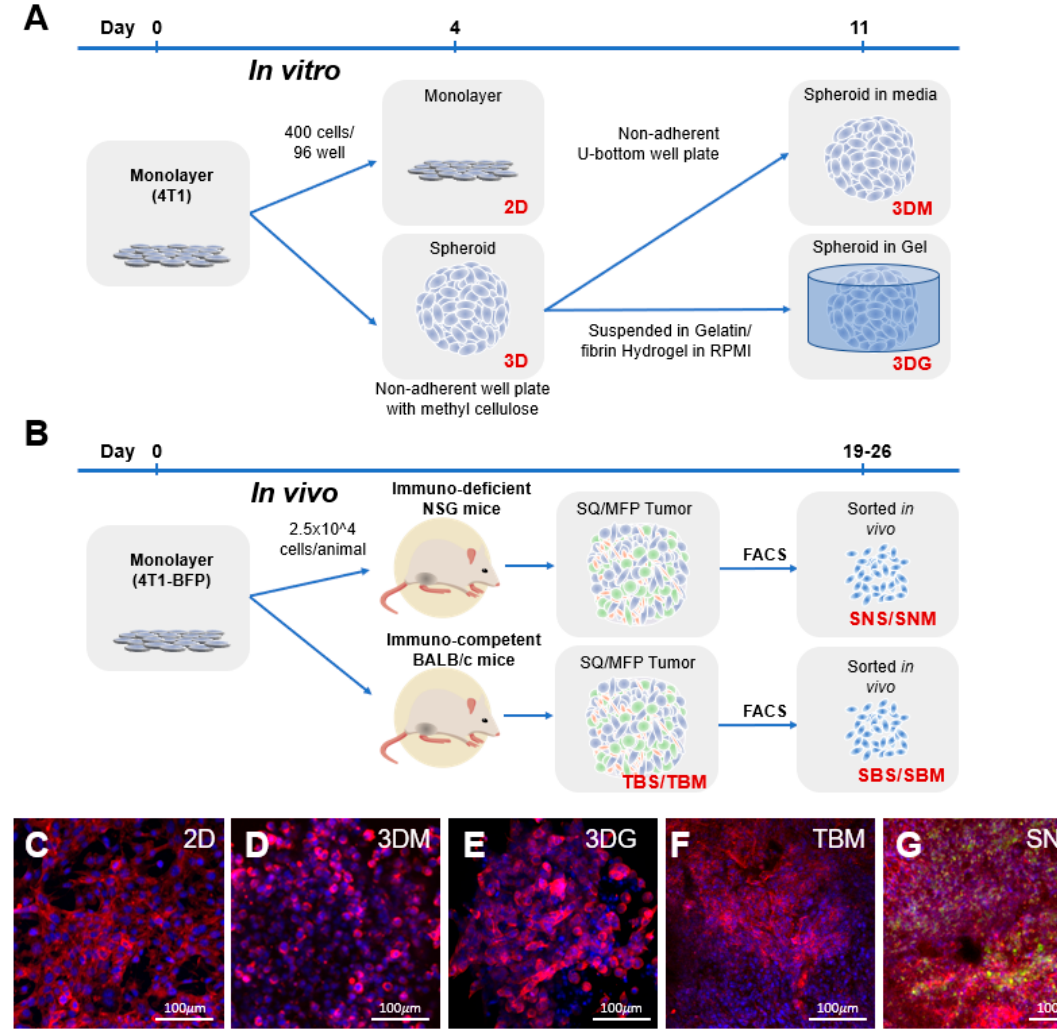
Figure 1. Experimental overview. ( A ) The 4T1 in vitro samples originated from low passage number, subconfluent, monolayer cultured cells seeded at 400 cells / well in 96 wells into tissue culture-treated flat-bottom plates or non-adherent U-bottom plates. Following 4 days of culture, monolayer ( C ) RNA was collected, and spheroids continued to be cultured in wells containing media ( D ) or cast into a gelatin / fibrin hydrogel ( E ) for an additional 7 days prior to RNA isolation. ( B ) In vivo tumor samples were generated by injection of subconfluent, monolayer 4T1-BFP cultures into mammary fat pad (MFP) or subcutaneously into (SQ) back flank locations in immunodeficient (NSG) or BALB / c mice. Tumors were isolated following a 19–26-day growth period yielding tumors ranging from 70 to 140 mm 3 . RNA samples were processed from bulk ( F ) or BFP + cancer cell populations isolated by fluorescently activated cell sorting (FACS) ( G ). Blue: nuclear DAPI staining; red: phalloidin staining actin filaments; green: BFP expression.